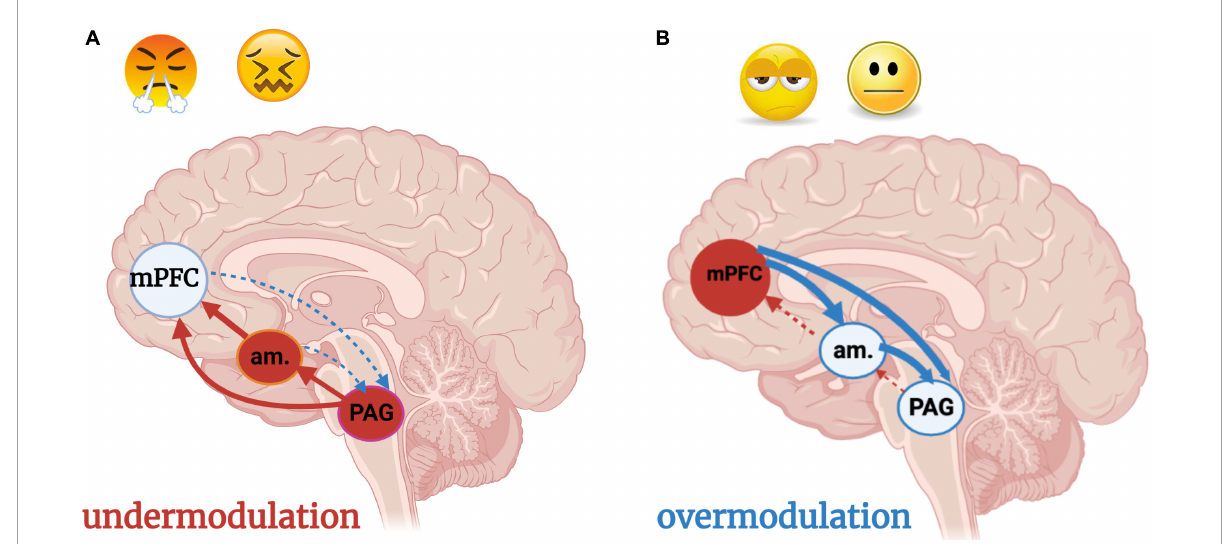
FIGURE9 (A,B) Under- and over-modulation of emotion and arousal in trauma-related conditions. Image adapted with permission from Nicholson et al. (2017). An individual who encounters a traumatic situation is flooded with negatively valenced sensory stimuli, resulting in hyperactivation of the brainstem and midbrain PAG. An individual who develops a post-traumatic condition experiences persistent over-or under-modulated activity of the PAG and amygdala, resulting in hyper- and hypo- sensory-affective responsivity, respectively, at the level of the PAG. (A) Under-modulation or bottom-up predominance (solid arrows) results in hyperarousal and weak top-down neocortical modulation (dashed arrows) of sensory input and emotions. Situations incorporating sensory or emotional stimuli similar to the traumatic event, often over-generalized with regard to valence (i.e., every sensation of butterflies in the stomach is labeled as a sign of danger) triggers hyperarousal and a fight/flight response. (B) Over-modulation of lower brainstem and midbrain arousal and alarm centers (amygdala, PAG) is driven by frontal neocortical regions including the mPFC. An individual who experiences chronic, repeated traumatization, such as an adolescent who has grown up in a household with domestic violence and physical abuse, adapts to persistent threat through top-down blunting and avoidance. The adolescent is emotionally numb, withdrawn from relationships, and dissociative due to a scarcity of bottom-up sensory integrative influence and processing. Subcortical regions are prevented from nourishing the cortex with either negative or positive raw affective feelings or sensations unless they are extreme. am, amygdala; mPFC, medial prefrontal cortex; PAG: periaqueductal